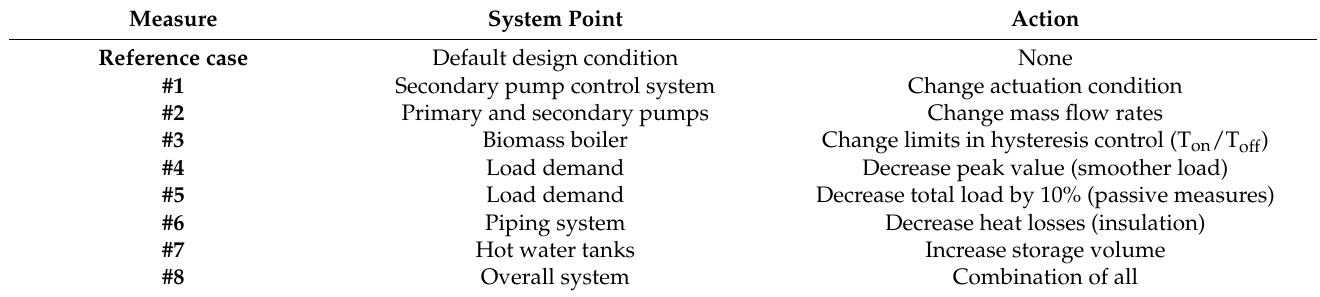
Table 9. Comparison of proposed measures based on simulation